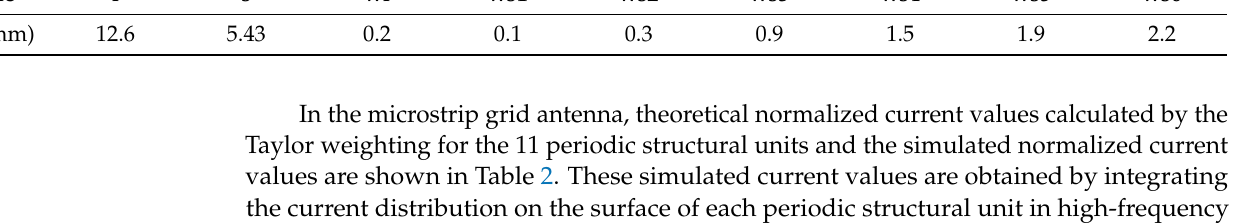
Table 2. Theoretical normalized current values calculated by Taylor weighting and simulated nor- malized current values for 11 periodic structural units. Periodic Structural Unit